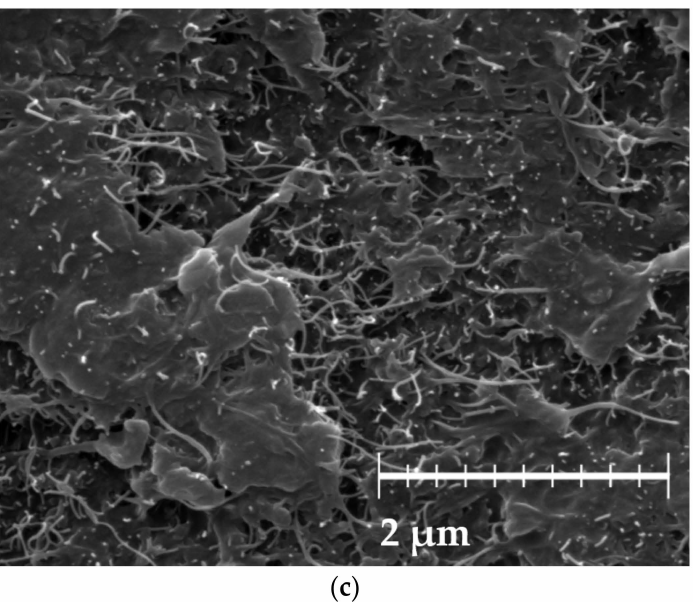
Figure 3. Electrical characteristics of CNT/EP coating; ( a ) current − voltage curves; ( b ) electrical conductivity; ( c ) SEM image.